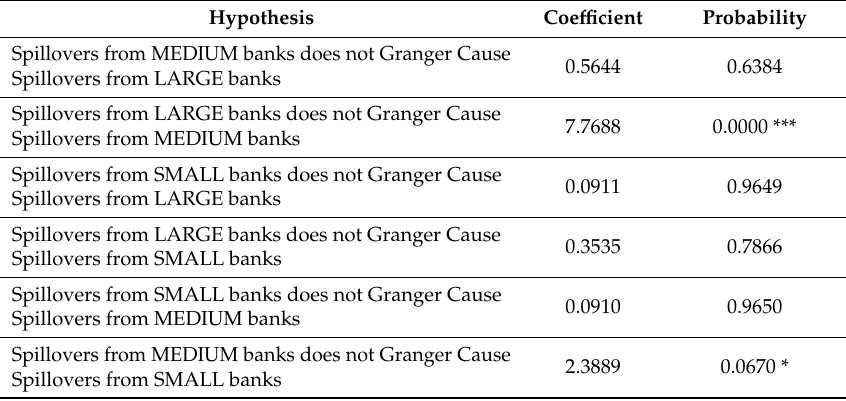
Table 4. Granger causality test for the size criterion, measured by total